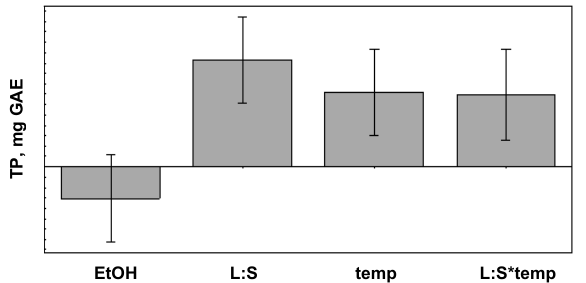
Fig. 1: Coefficient plot of the considered factors (EtOH, ethanol %; L:S, L:S ratio; temp, temperature) for total phenol (TP) response.